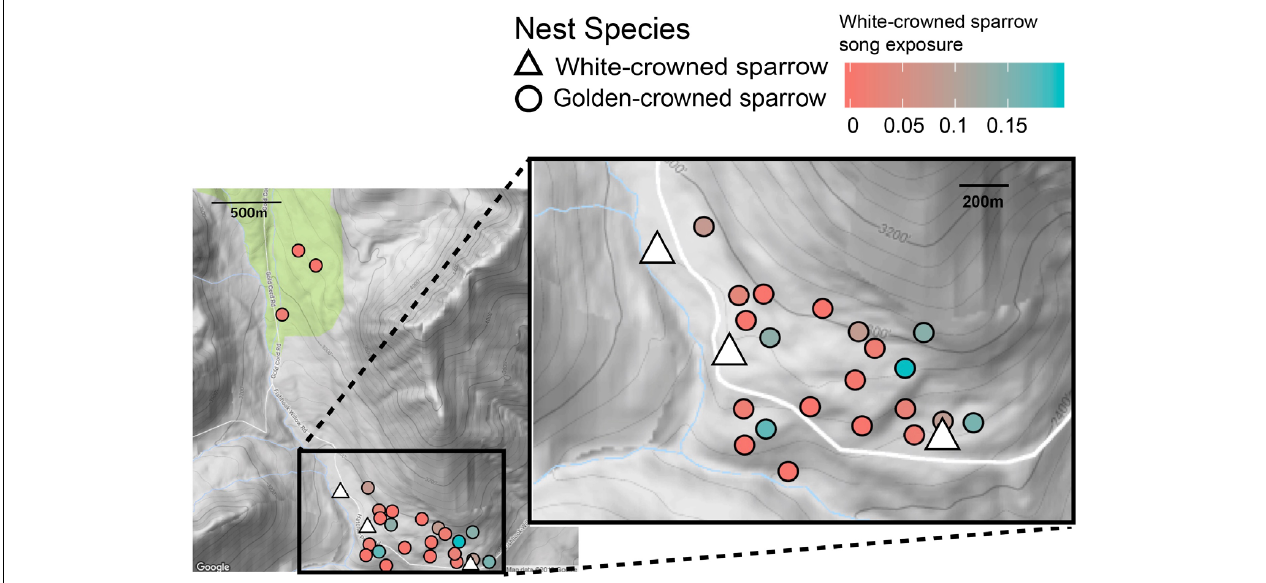
FIGURE 1 | Positions of nests of playback subjects at Hatcher Pass Management area. White triangles represent active white-crowned sparrow nests; circles represent golden-crowned sparrow nests, with color representing the ratio of white-crowned sparrow song to total Zonotrichia songs recorded at that nest. At these golden-crowned sparrow nests, we exposed golden-crowned sparrows to playbacks of golden-crowned and white-crowned sparrow song and measured the response of nestlings in number of chirps during the playback period. Inset shows a detail of the densest area of nests. Interestingly, the proportion of heterospecific song at a golden-crowned sparrow nest does not seem to be predicted by its distance to the nearest white-crowned sparrow